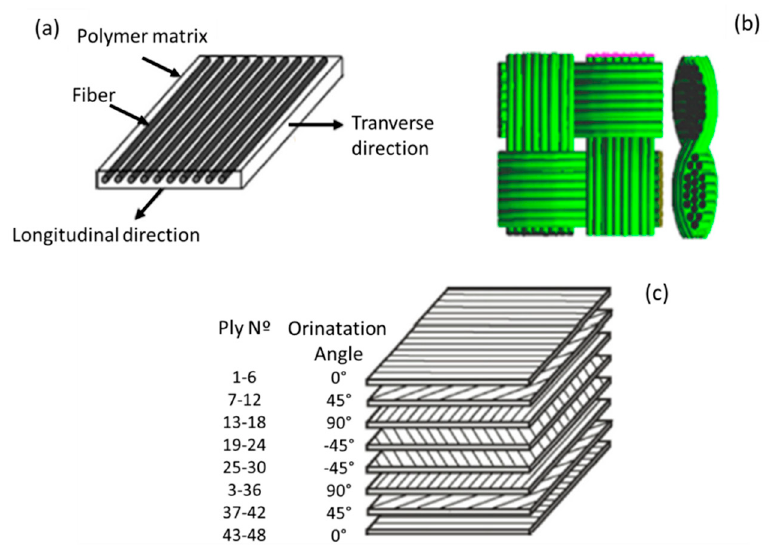
Figure 1. Scheme of the most common uses of fiber reinforced composite structures: ( a ) unidirectional fiber orientation ply, ( b ) bidirectional fiber orientation ply (woven-ply) and ( c ) multiorientation laminate, quasi-isotropic laying-up sequence [0°/45°/90°/ − 45°] 6S. Reproduced with permission [13] .